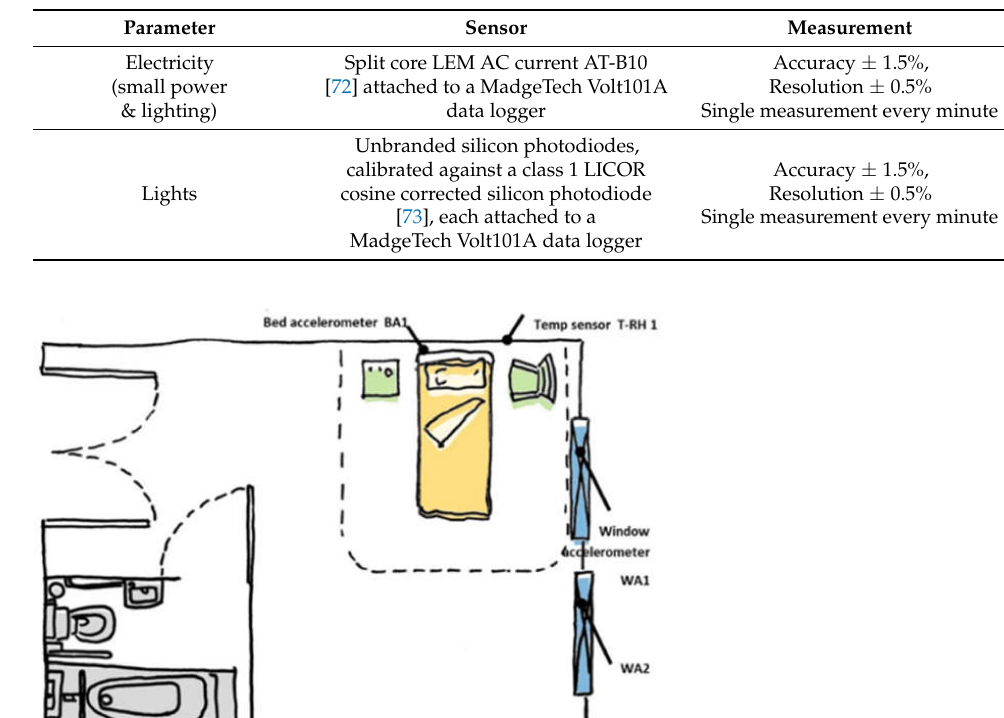
Table 2. Energy sensor specifications (accuracy, resolution, sampling rate) for electricity and lights.